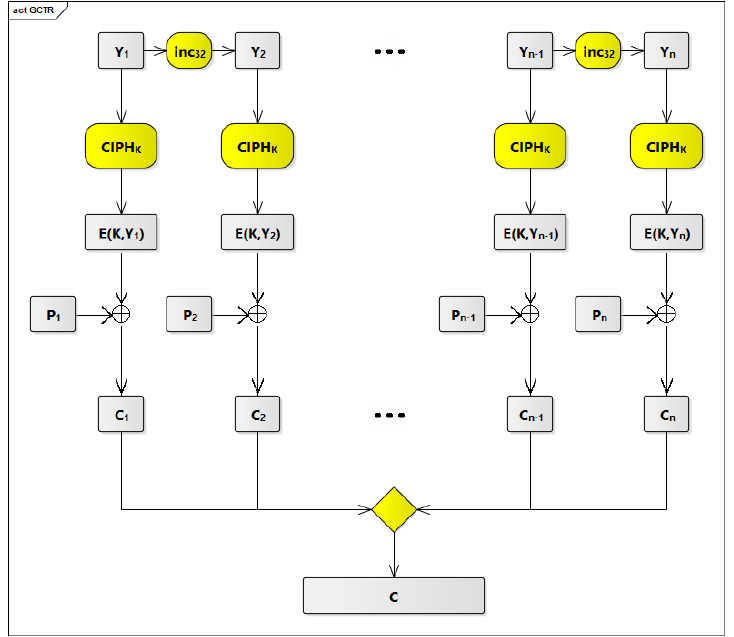
Figure 6. The GCTR K